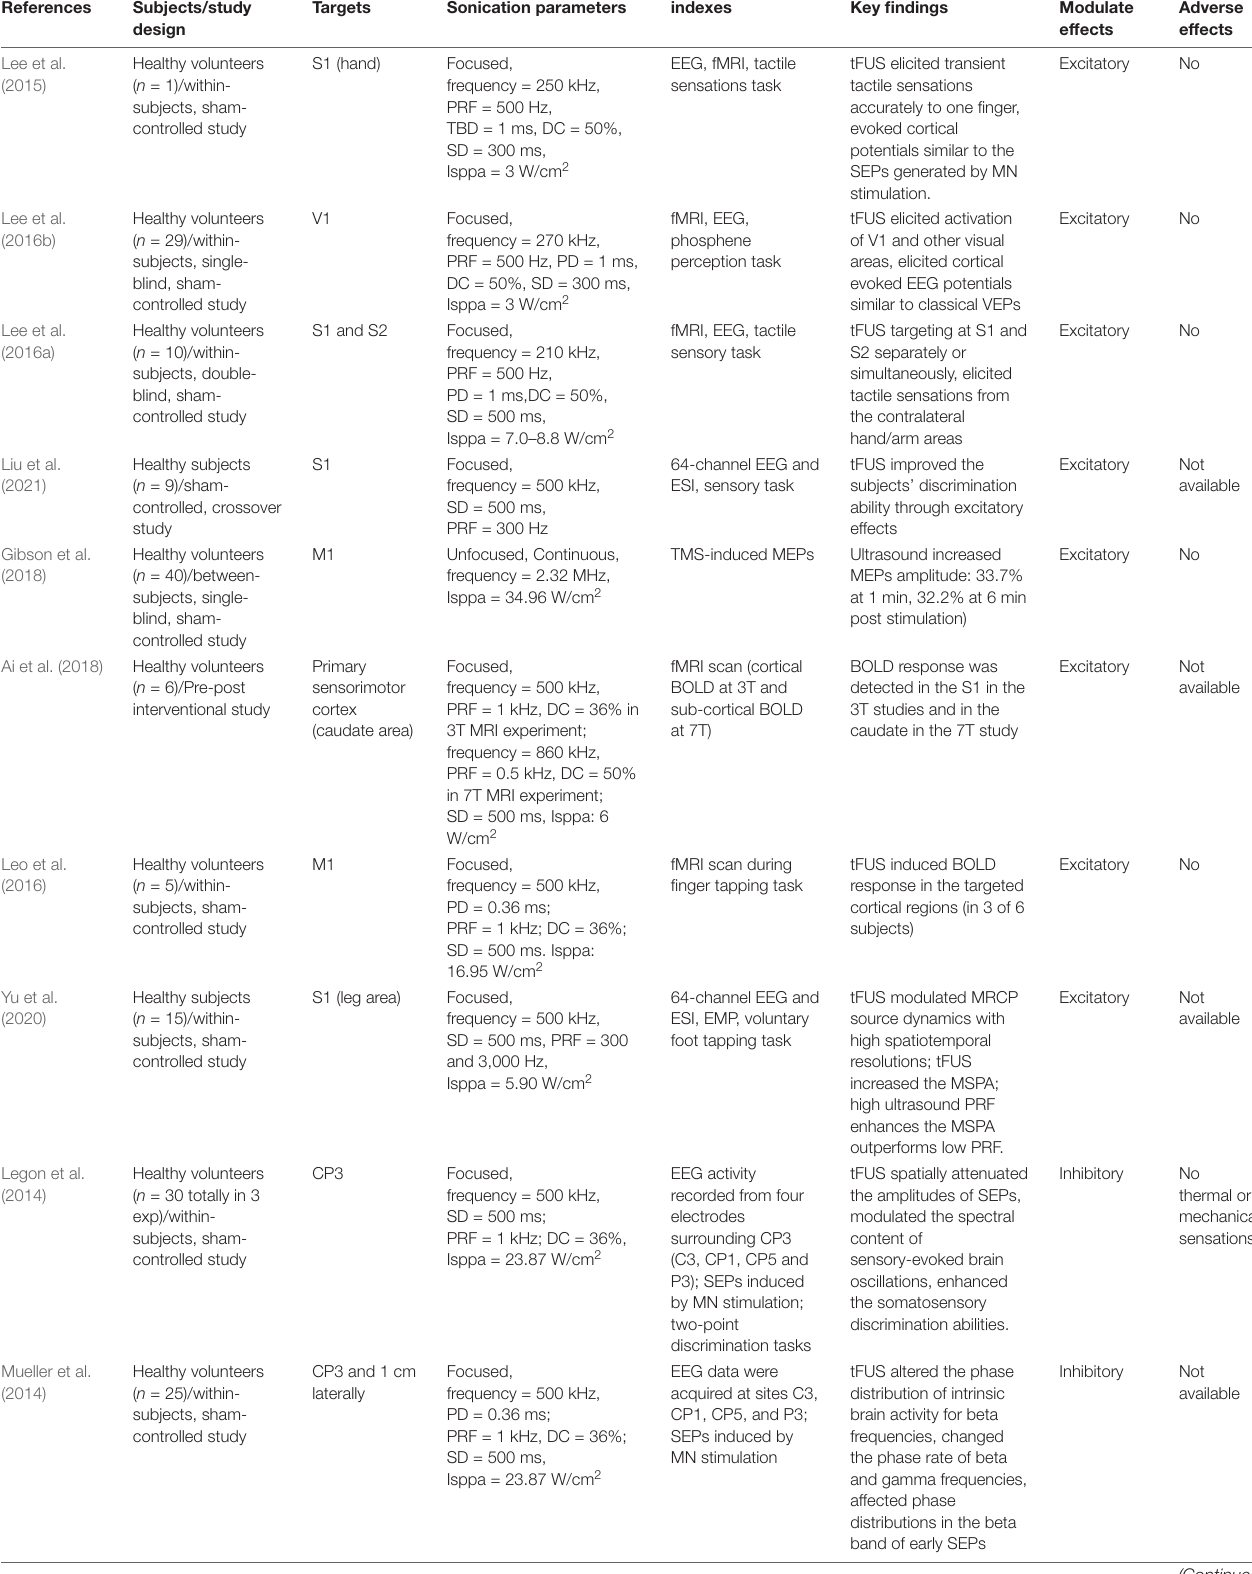
TABLE 2 | tFUS neuromodulation studies in